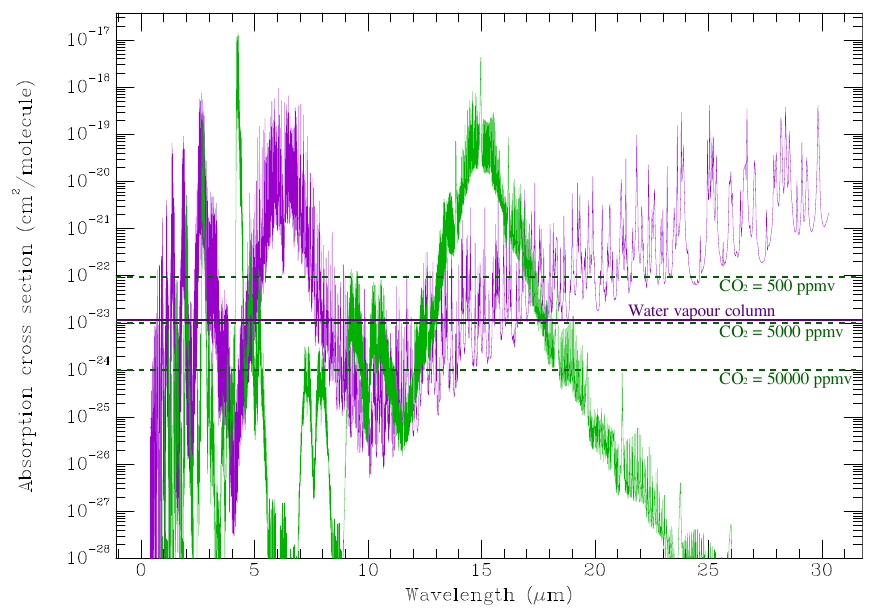
Fig. 9. Absorption cross sections for CO 2 (green) and water vapour (purple) from HITRAN (shown at 900hPa and 285K). Horizontal lines indicate the cross section for which the gas has an optical depth of unity, solid purple for the GAM water vapour column, dashed green for various CO 2 concentrations. The column depth of the atmosphere is 2.1 × 10 25 moleculescm − 2